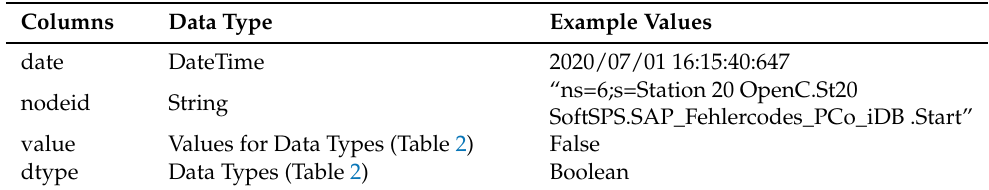
Table 1. OPC UA Log File Format [6]. Reprint with permission from [6], “CONTEXT: An